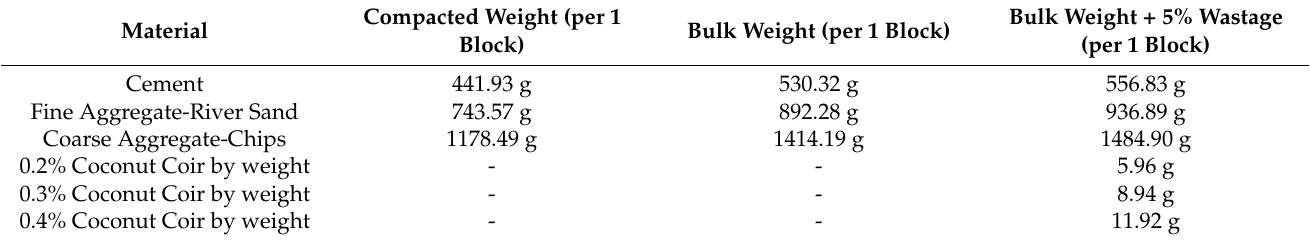
Table 5. Material Quantity Calculation.